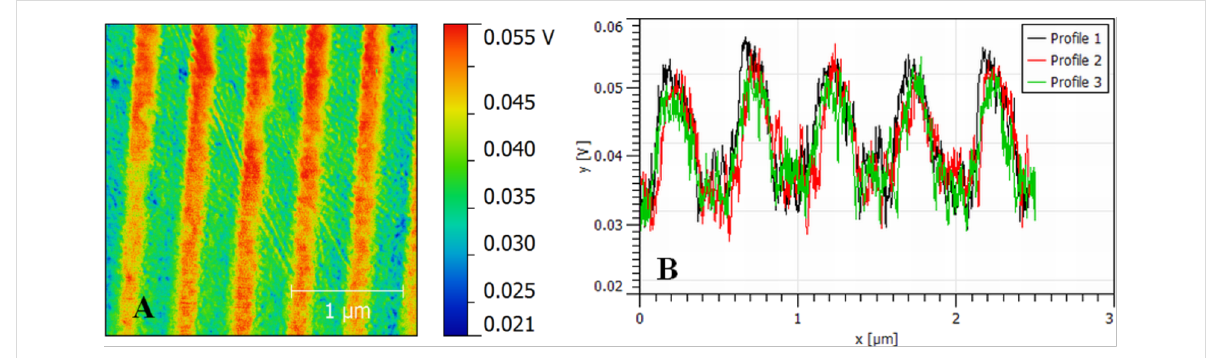
The applicability of the partial diffusion of the Au layers was tested by the photodiffusion of the 20 nm Au layer into Bi 2 Se 3 by UV source through a Ronchi ruling [64,65]. The illuminated Au–Bi 2 Se 3 exhibited a periodical pattern of the surface poten- tial with an amplitude of 20 mV (Figure 9). This value is slightly lower in contrast to the NIs obtained by e-beam irradia- tion of the 20 nm Au layer (decrease 29 mV), and could be connected with the partial lateral diffusion of the heat or Au atoms/ions. In this way, the possibility to prepare a